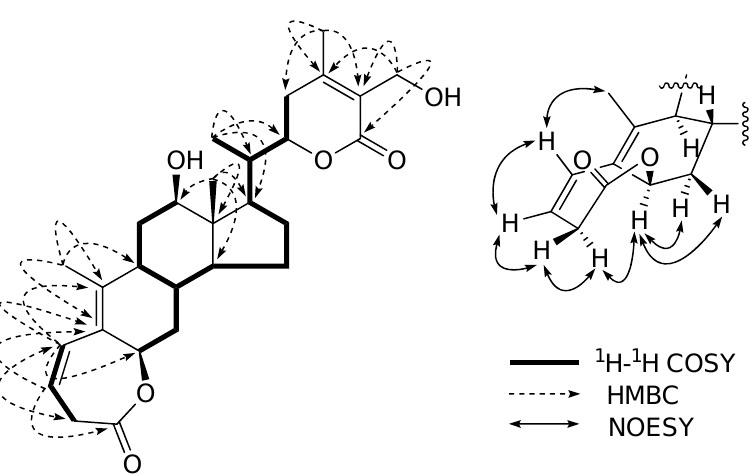
Figure 2. Key 1 H- 1 H COSY and HMBC correlations of 1